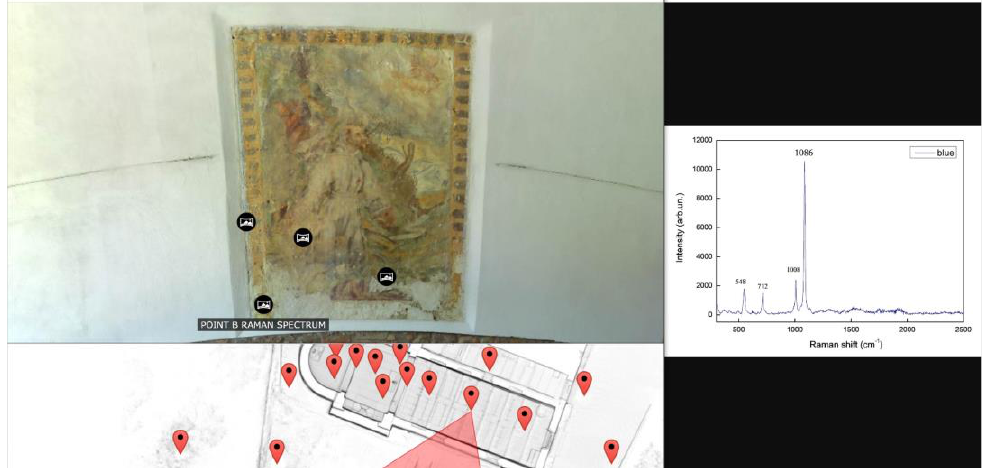
Figure 18. Example of interactive VT: clicking the icons, it is possible to see the relating results of spectroscopic analyses.